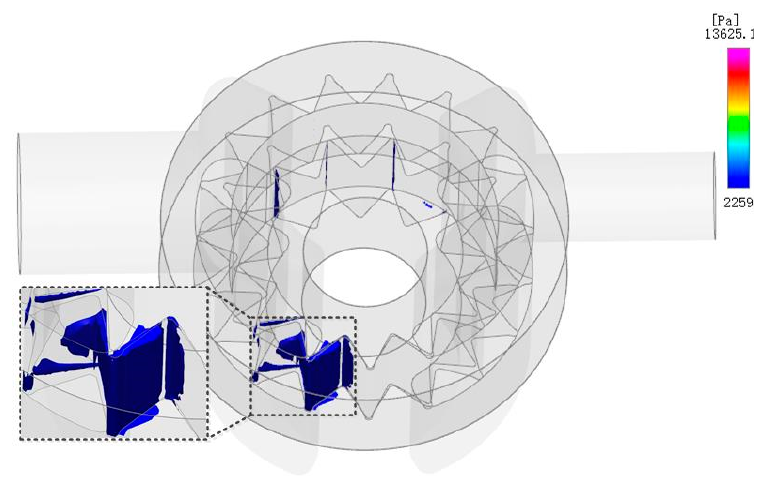
Figure 13. Oil distribution area when the absolute pressure is lower than 3000 Pa.